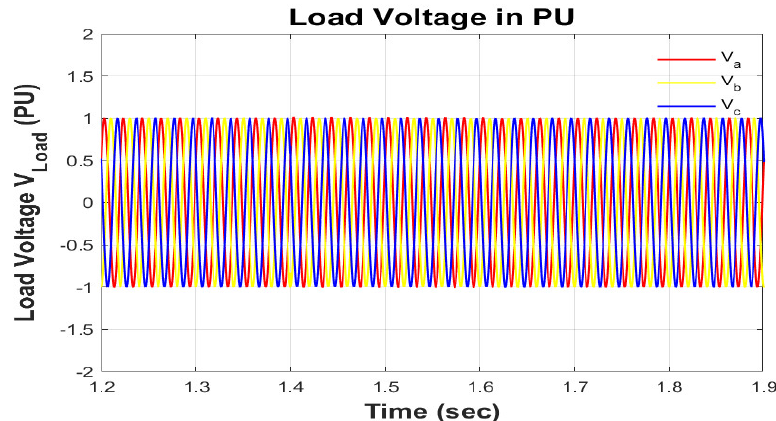
Figure 22. Load voltage during L − G fault.